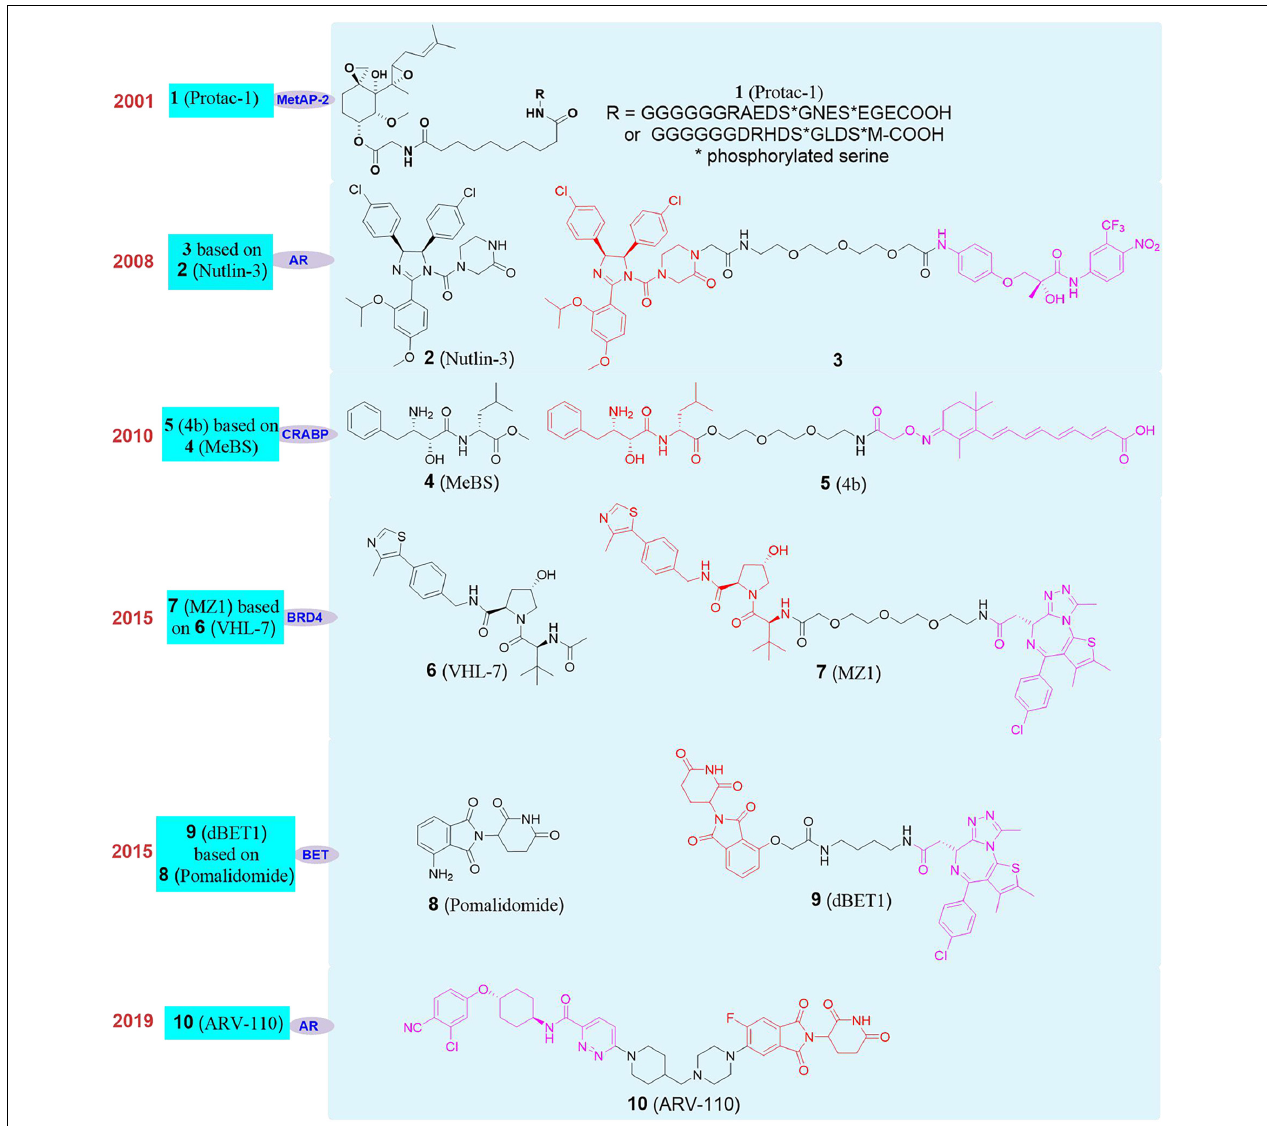
FIGURE 4 | The development and structures of representative E3 ligands and